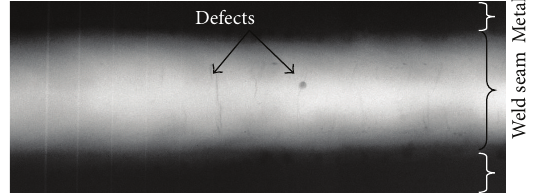
Figure 2: Example of weld radiography image with defects: porosi- ties (circular) and a longitudinal